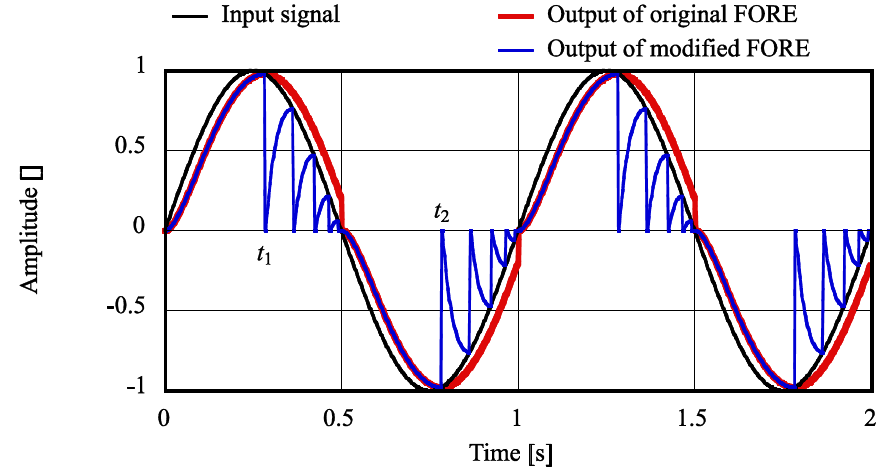
Figure 3. Simulated time history of the input and output signals in both FOREs. Black line: input signal; heavy red line: output signal of original FORE; blue line: output signal of modified FORE.